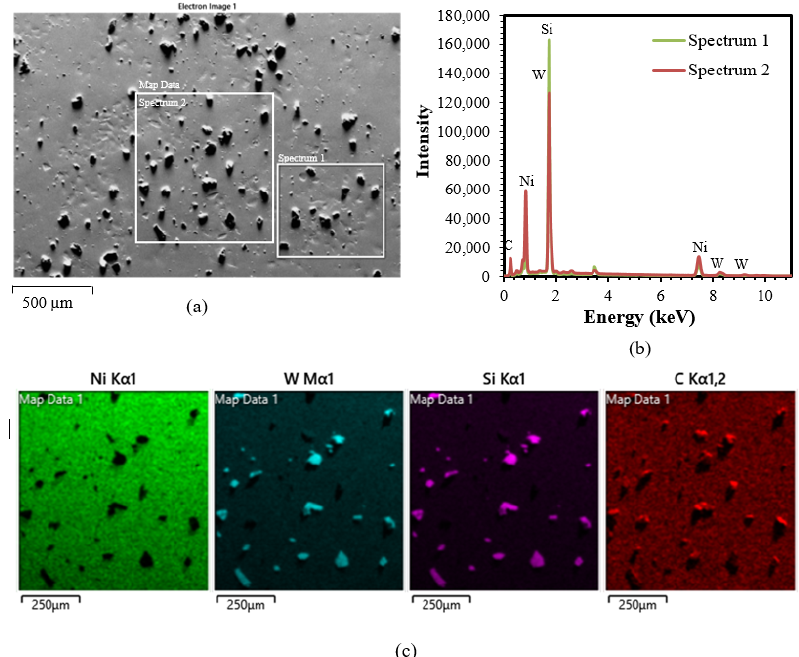
Figure 5. SEM micrograph ( a ), EDS spectra ( b ), and X-ray mapping ( c ) taken from the surface of the NiW–SiC coating; EDS spectra and EDS map of the area are highlighted with white rectangles in the SEM image.